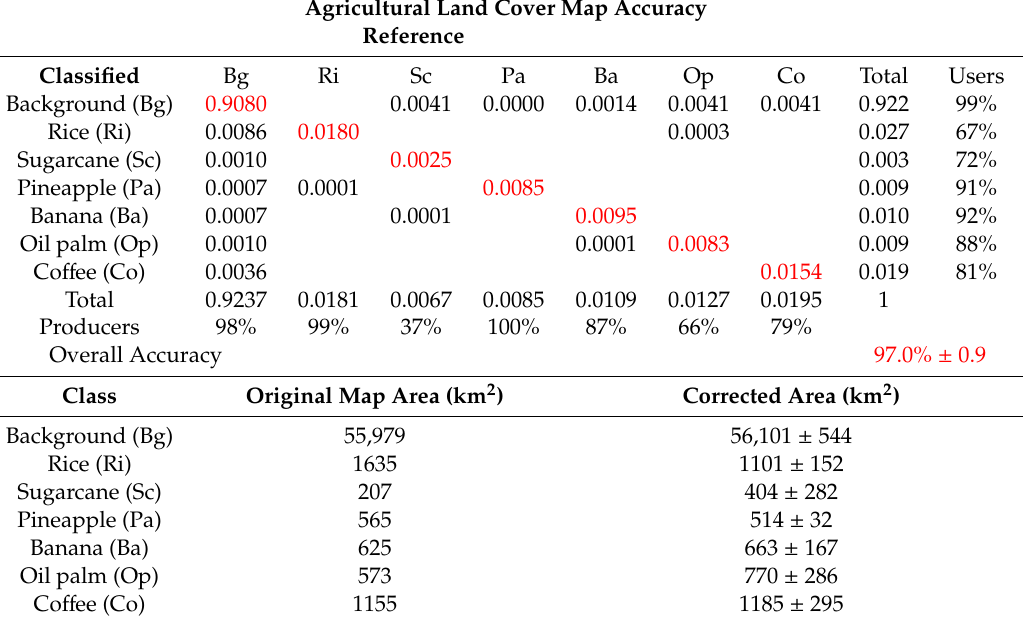
Table 3. Confusion matrix for the 2015 agricultural land cover map, displayed as a proportion of map area [59]. Area-corrected estimates of overall accuracy and class area (mean ± confidence interval), the per-class errors of omission (Producer’s accuracy), and the per-class errors of commission (User’s accuracy) are shown. See Table A3 for the uncorrected accuracy estimate. Red numbers indicate accurate classifications and the resulting overall accuracy.